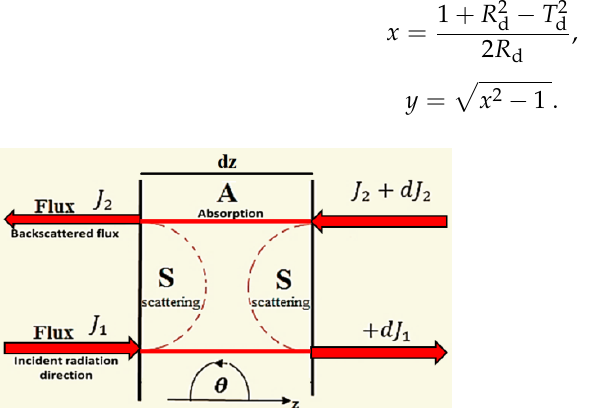
Figure 4. The calculation of two radiation fluxes in the Kubelka − Munk model.